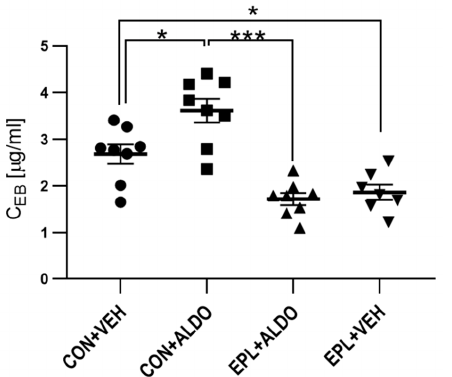
Figure 4. Changes in vascular permeability after chronic EPL administration. n = 7–8; n for each group is the number of skin samples, not the number of animals; 8 rats were used in this experiment; data are presented as mean ± SEM and individual values; ALDO—aldosterone; C EB —Evans blue concentration per gram of skin tissue; CON—EPL solvent; EPL—eplerenone; VEH—ALDO solvent; * p < 0.05; *** p < 0.001.